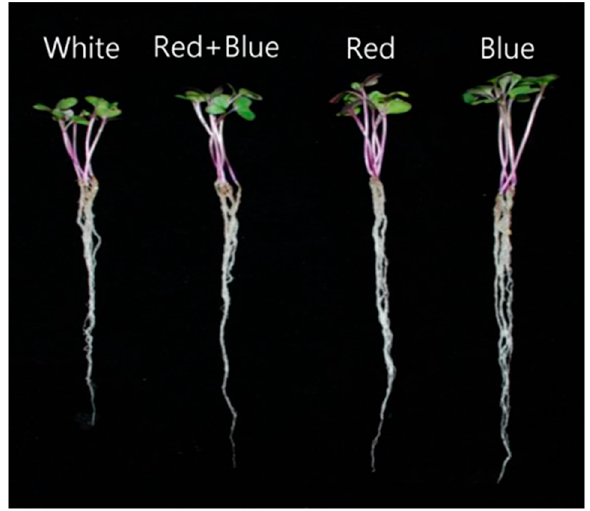
Figure 1. Development of kohlrabi sprout at 10 days of growth under white, blue, red, and blue + red LED lights.